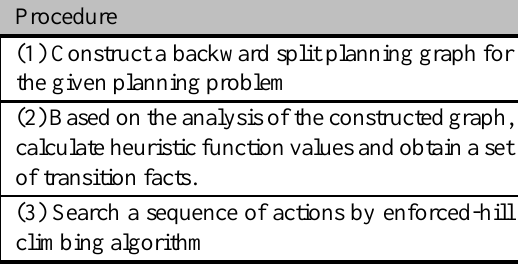
Table 1. Procedure of a backward split planning Procedure